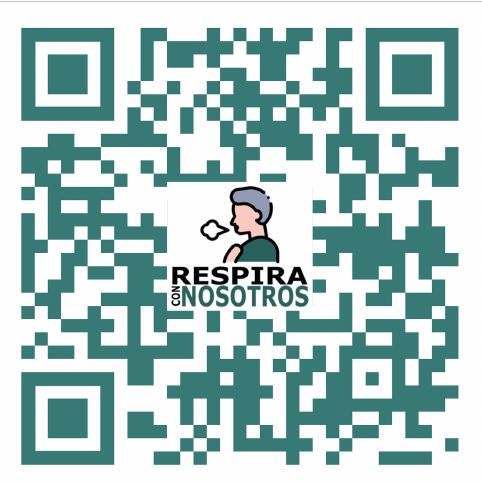
Figure 3. QR Code from the